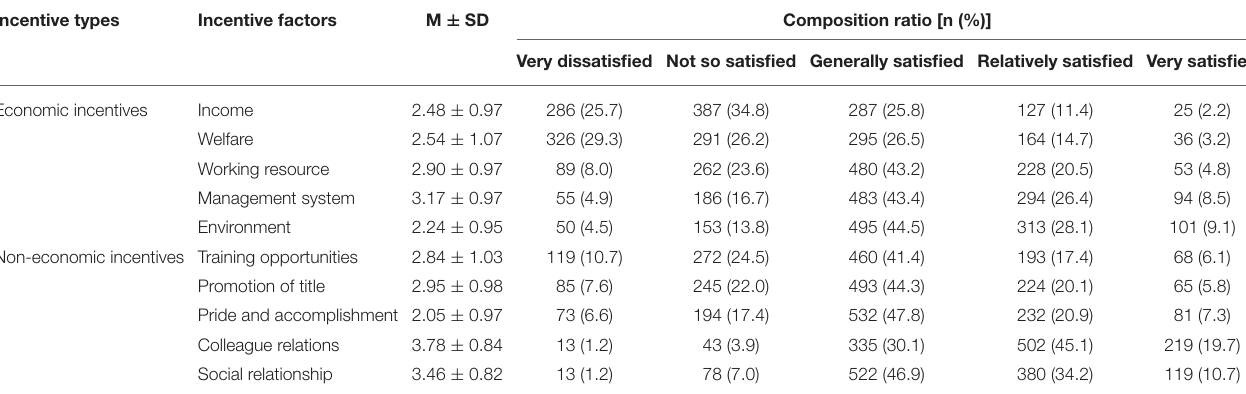
TABLE 2 | Description of the relative level of incentive factors preference and satisfaction degrees.